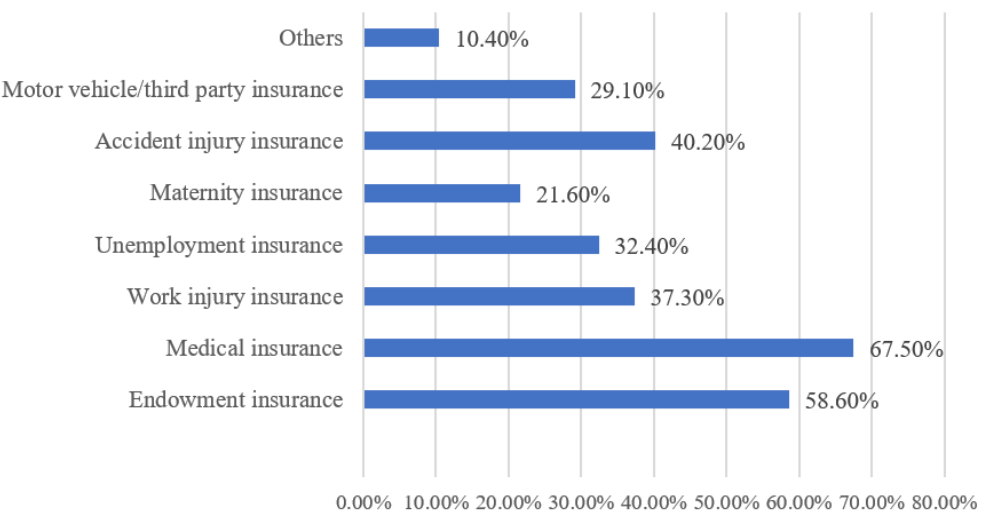
Figure 3. Percentage of Cases with the “Social Security Paying” Option.